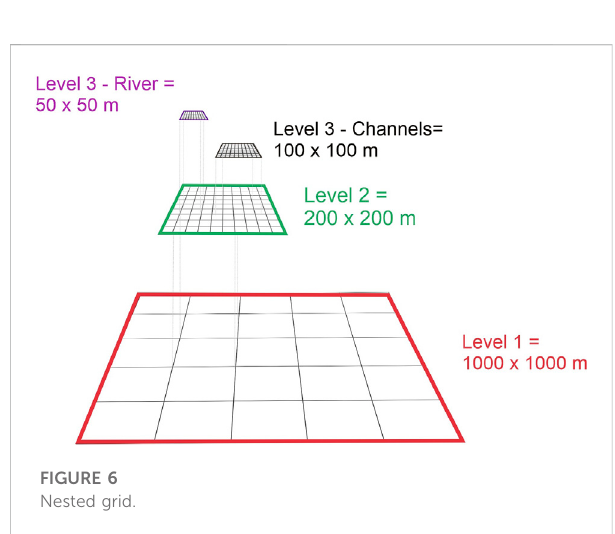
main categories: standard regression statistics (Pearson Correlation